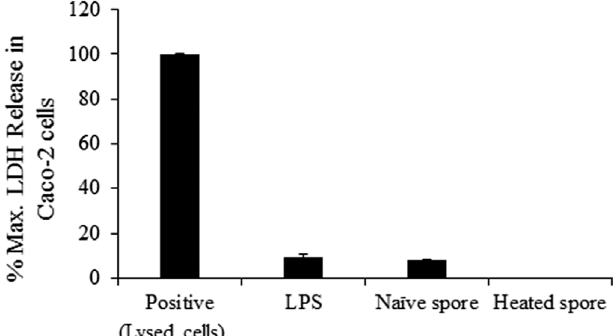
Figure 4. Analysis of cytotoxicity in Caco-2 cells following exposure to naïve and heated spores of Kudoa septempunctata . Cytotoxicity was measured based on LDH release. Data are presented as mean ± SE of three independent experiments performed in